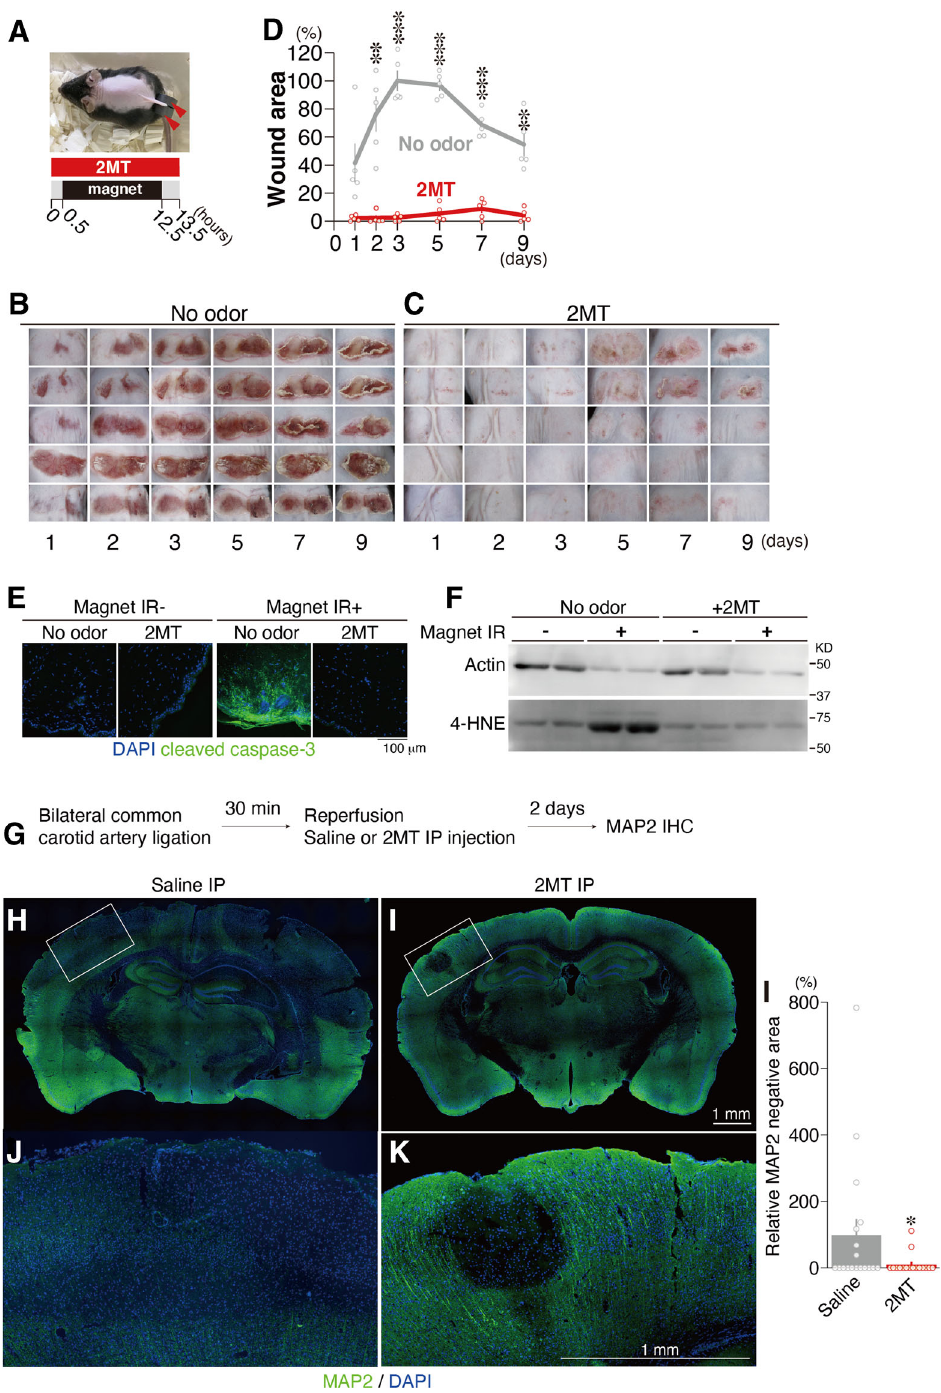
Fig. 4 Suppression of ischemia/reperfusion injury by innate fear stimuli. A Timeline of cutaneous ischemia/reperfusion experiments. B – D Photographs of cutaneous ischemia/reperfusion lesions for the no-odor control ( B ) and 2MT-treated ( C ) animals at each time point after reperfusion ( n = 5 each). The percentage of lesioning at each time point after reperfusion with (red) and without (gray) 2MT stimulation relative to the wound area in the no-odor condition 3 days after reperfusion is also shown ( D ). E Representative images of immunohistochemistry for cleaved caspase-3 in the control (magnet IR − ) and ischemia/reperfusion (magnet IR + ) areas with and without 2MT administration. F Immunoblots of actin and 4-HNE in cutaneous lysates from control (magnet IR − ) and ischemia/reperfusion (magnet IR + ) areas. G – L Timeline of cerebral ischemia/reperfusion experiments ( G ), and representative images of immunohistochemistry for MAP2 in coronal brain sections from the saline and 2MT-treated animals ( H – K ). The areas indicated by white boxes in ( H and I ) are magni fi ed and shown in ( J and K ). The mean percentages of MAP2-negative areas are also shown for both groups ( L ; n = 18 for the control group and n = 16 for 2MT-treated group). The size of the MAP2-negative area for the saline condition was set at 100%. Data are means± SEM. Student ’ s t test or Mann – Whitney test was performed. * P < 0.05; ** p < 0.01; *** p <